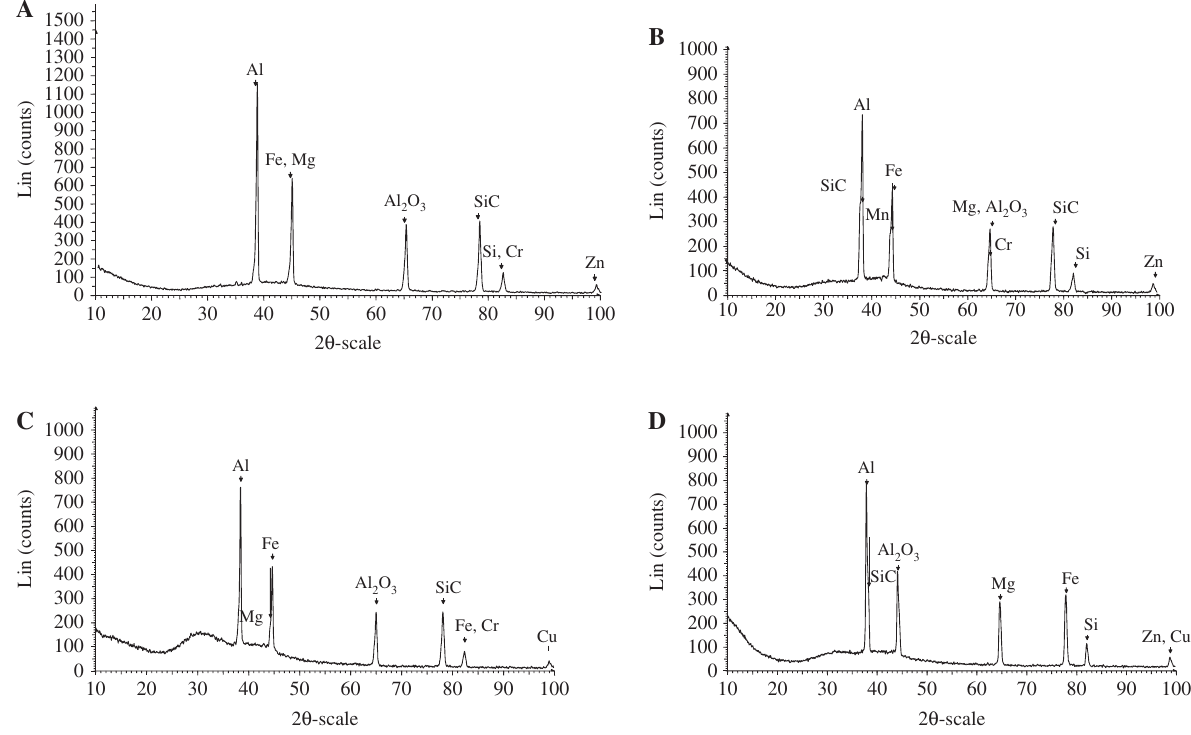
O hybrid composite: (A) 5 wt%, (B) 10 wt%, (C) 15 wt%, (D) 20 2 3